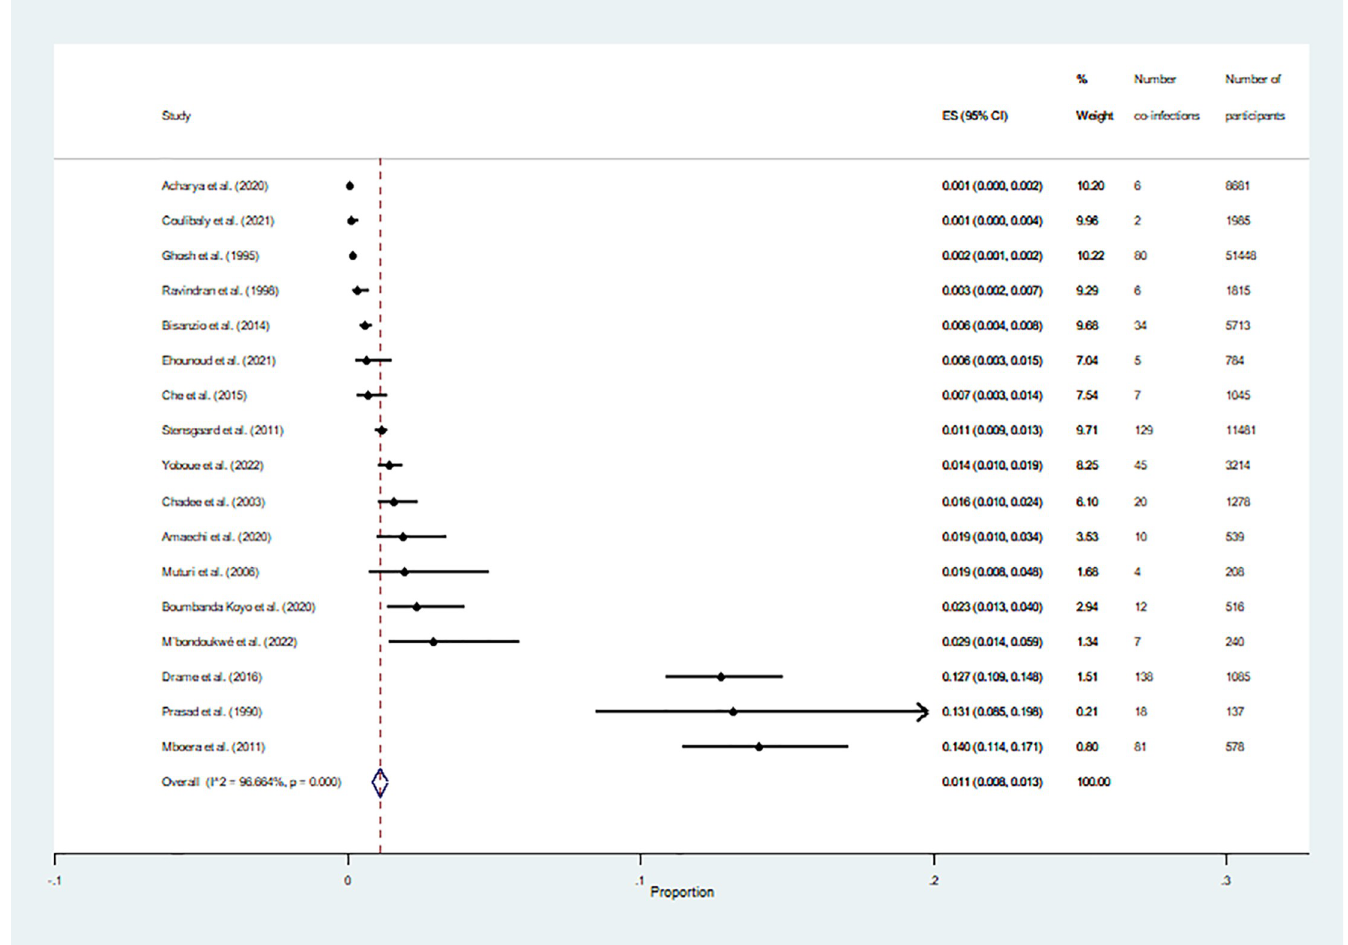
Fig 3. Pooled prevalence of malaria and filariasis co-infection among selected studies. Abbreviations : ES- prevalence estimate; CI- confidence interval.